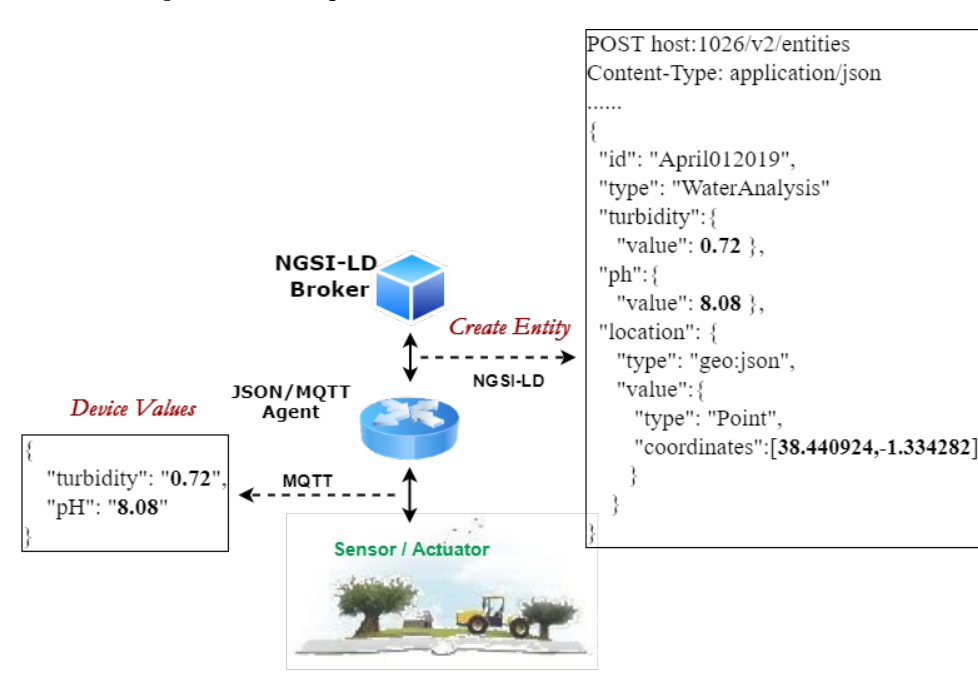
Figure 3. Data model from Internet of Things (IoT) level to